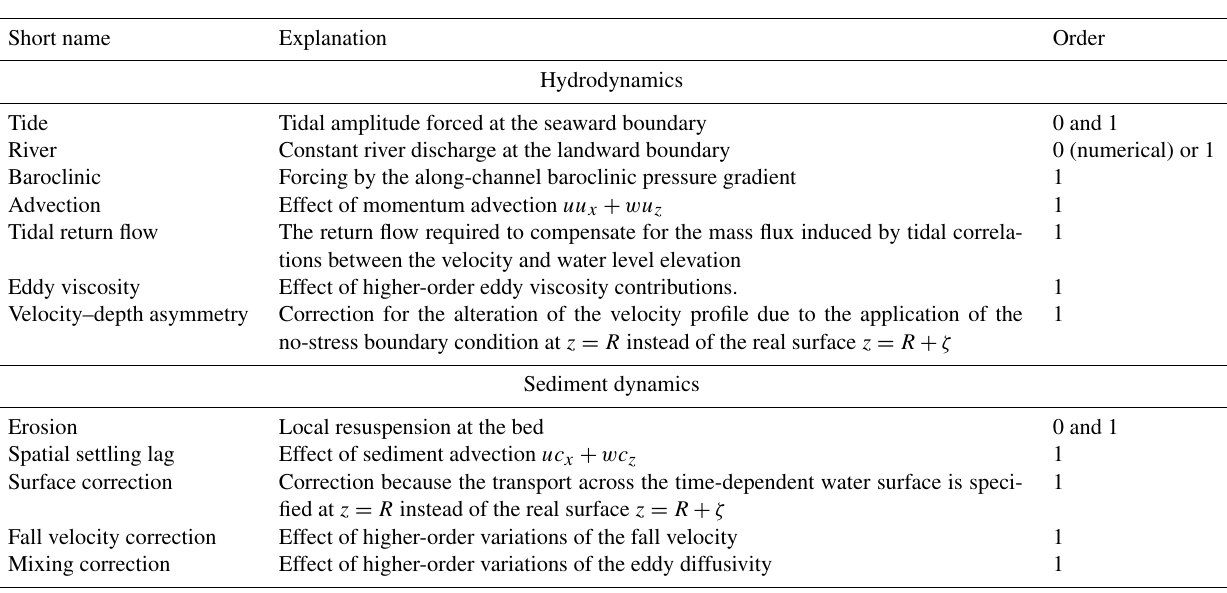
Table 2. Separate forcing mechanisms to the water and sediment motion and the order at which these mechanisms